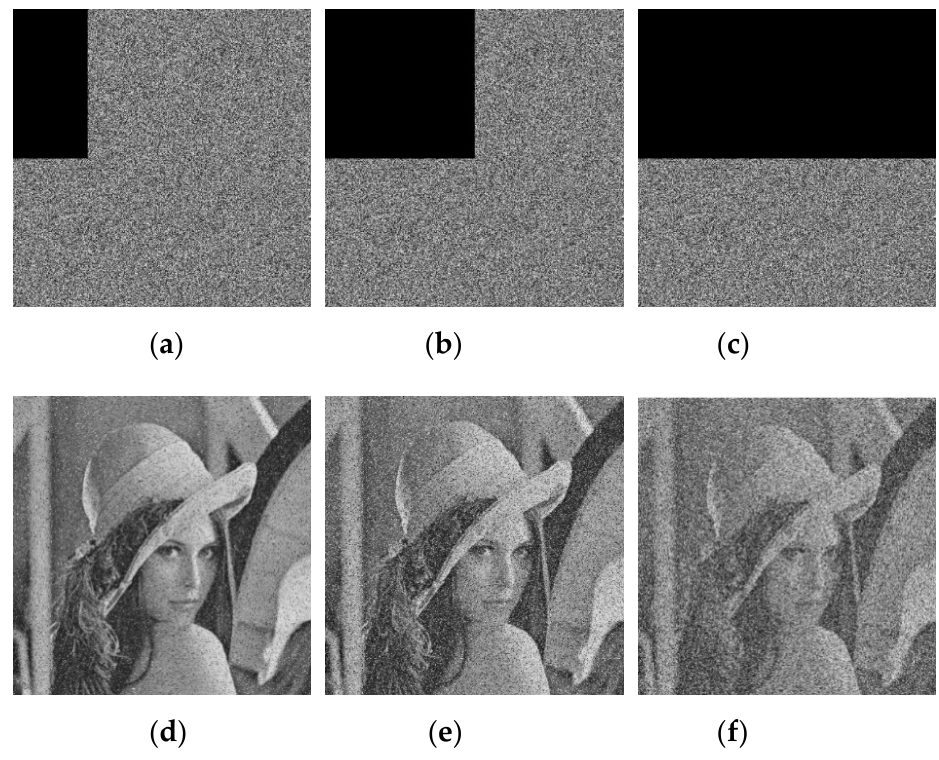
Figure 20. The results of cropping attack: ( a ) 12.5% cropping; ( b ) 25% cropping; ( c ) 50% cropping; ( d ) Decryption of ( a ); ( e ) Decryption of ( b ); ( f ) Decryption of ( c ).